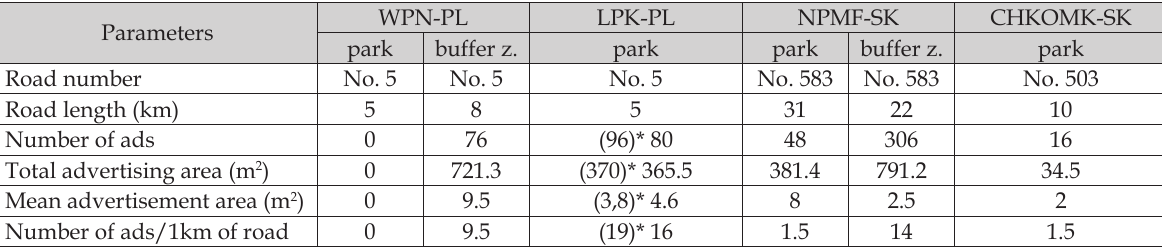
Table 3. Characteristics of the advertising phenomenon in the investigated parks.